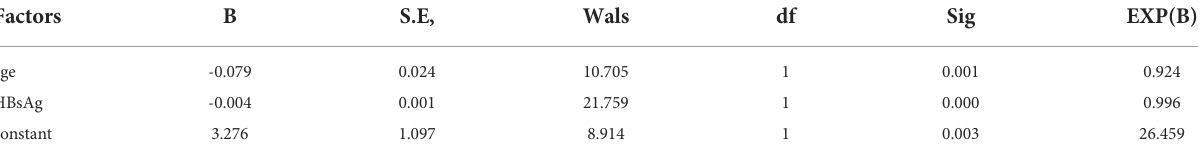
TABLE 5 Logistic regression analysis of week 48 HBsAg seroconversion in all patients.